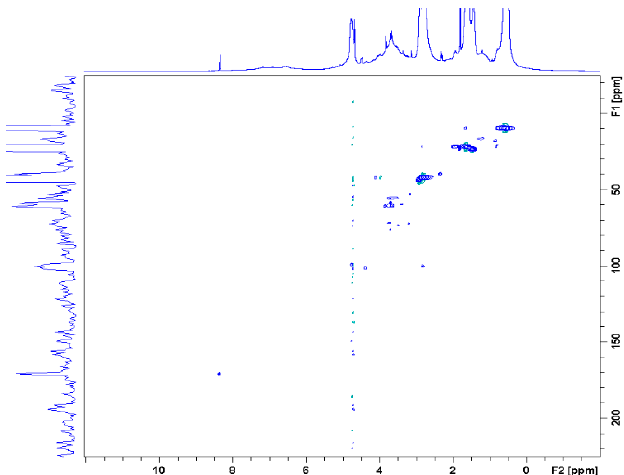
Figure 8. Two-dimensional 1 H- 13 C HSQC NMR spectrum ( δ C / δ H 0–220 / 0–12 ppm) of the HA-APTS hybrid precursor.